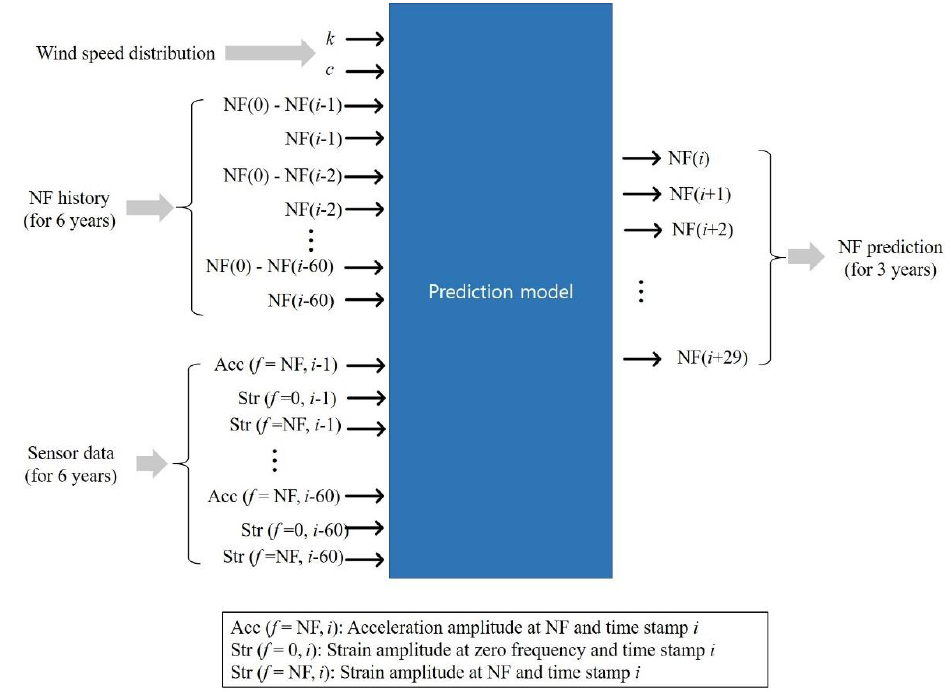
Figure 5. Established OWT NF prediction model. The model inputs consist of six-year virtual sensor data and the wind speed Weibull distribution parameters; the model output consists of a three-year NF prediction.